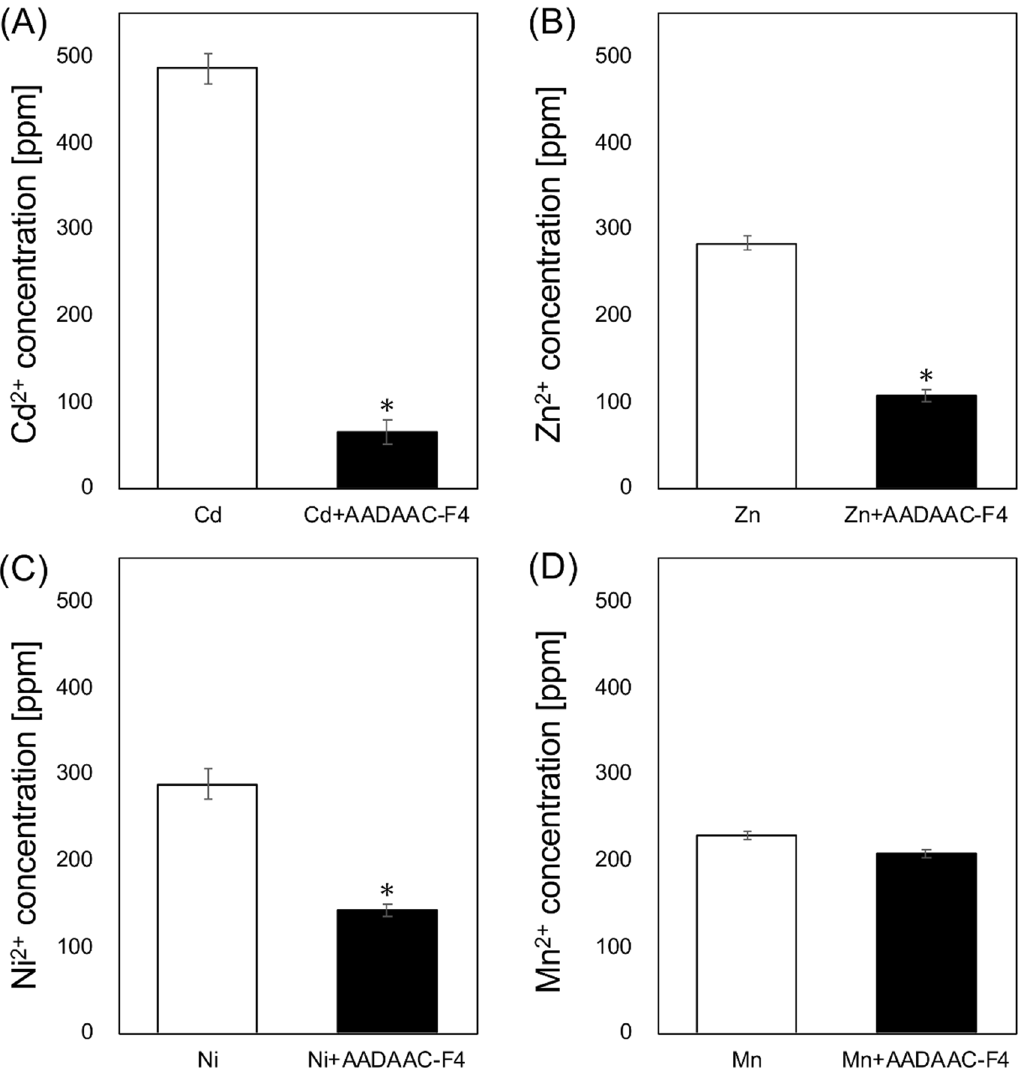
Figure 4. Metal binding affinity of AADAAC-F4 analogues. AADAAC-F4 was dissolved in Tris–HCl buffer solution (50.0 mM Tris, 599 mM NaCl, pH 8.0) at a concentration of 10 mg/mL (4.26 mM) and equimolar amounts of ( A ) Cd 2+ , ( B ) Zn 2+ , ( C ) Ni 2+ , and ( D ) Mn 2+ , dissolved in 1 M HNO 3 , were added. After incubation at 50 °C, the concentration of each metal ion in the supernatant was measured by ICP-MS. * P < 0.05 in a t -test between the concentration after treatment with each peptide compared to that of the control in each